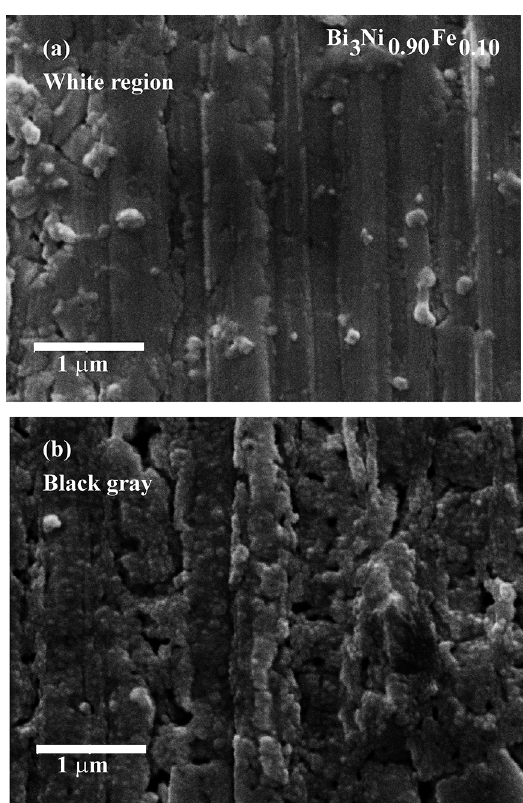
Ni Fe 3 0.90 0.10